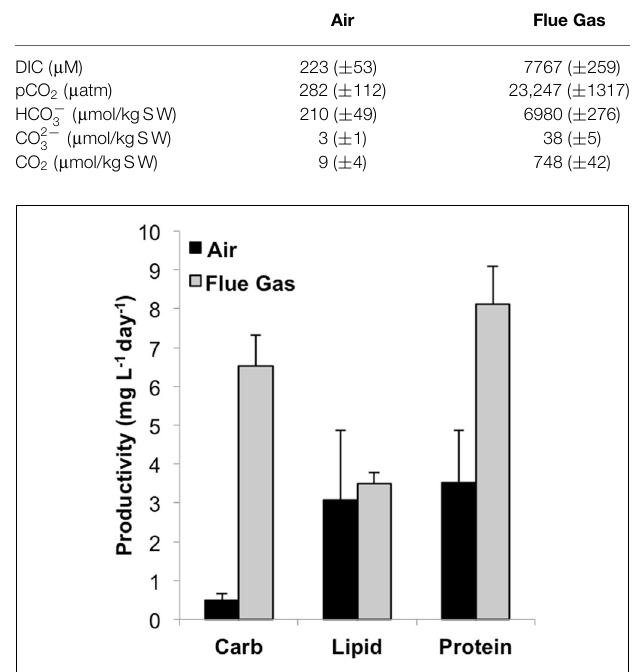
FIGURE 1 | Carbohydrate, lipid, and protein productivity for Heterosigma akashiwo bubbled with air (control) or simulated flue gas containing 12% CO 2 and 150ppm NO . Data plotted are mean values ± SD ( n = 4).